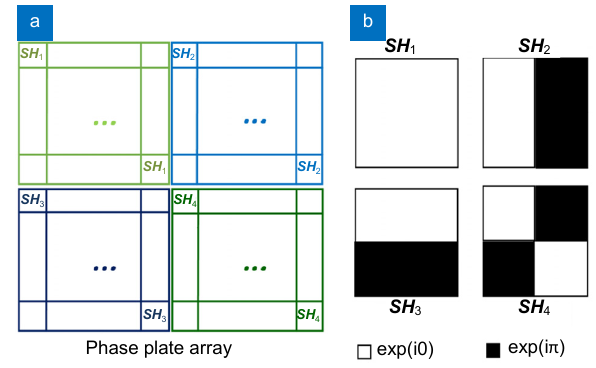
Fig. 3 | ( a ) An example for PPA: the 2-order PPA is composed of 4 sub-phase plates, which are constituted by four phase patterns SH 1 , SH 2 , SH 3 and SH 4 respectively. ( b ) The four phase patterns are formed by the first, second, third and fourth rows of H (4)